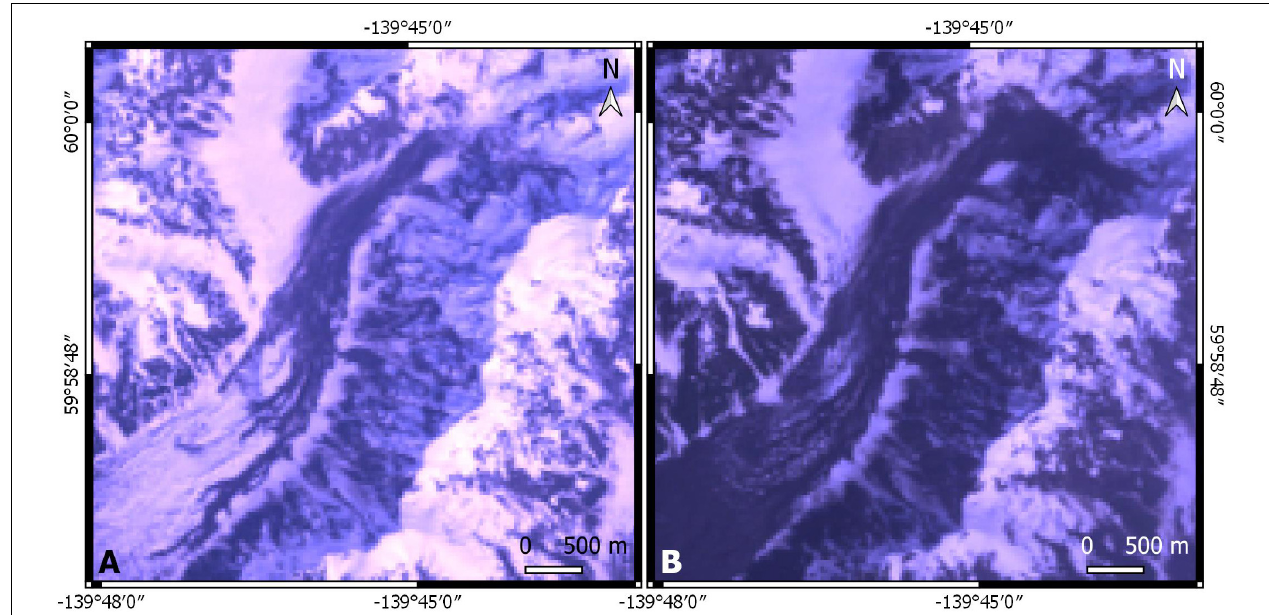
FIGURE 6 | Landsat images acquired on (A) 2 July 1992 and (B) 10 August 1992, showing the rapidly reworked deposit of RA 36 (event occurred between 4 April and 22 May 1992) on Atrevida Glacier.